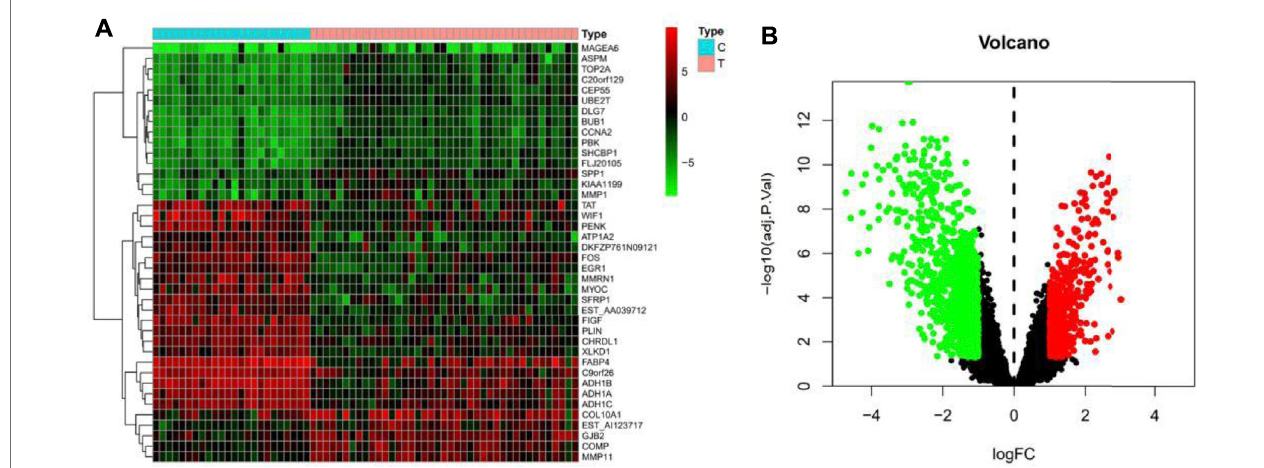
FIGURE 1 | (A) The heatmap of breast cancer target genes; (B) The volcanic map of breast cancer target genes. Green represents down-regulated genes; black represents no difference in genes, red represents up-regulated genes.